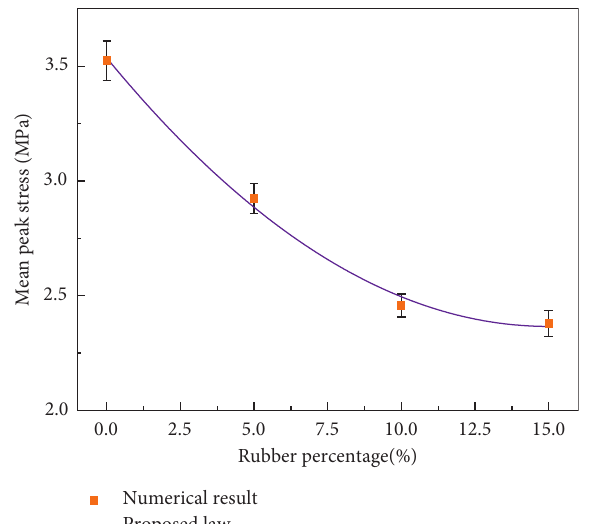
Figure 23: Effect of rubber volume fraction on peak stress for rubber replacing aggregate